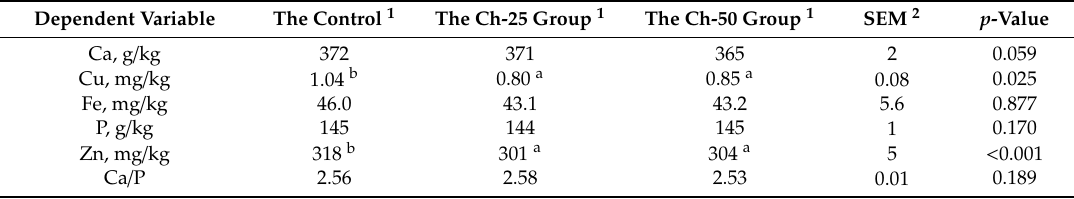
Table 8. Bone macro- and microelements content in tibia of 16-week-old male